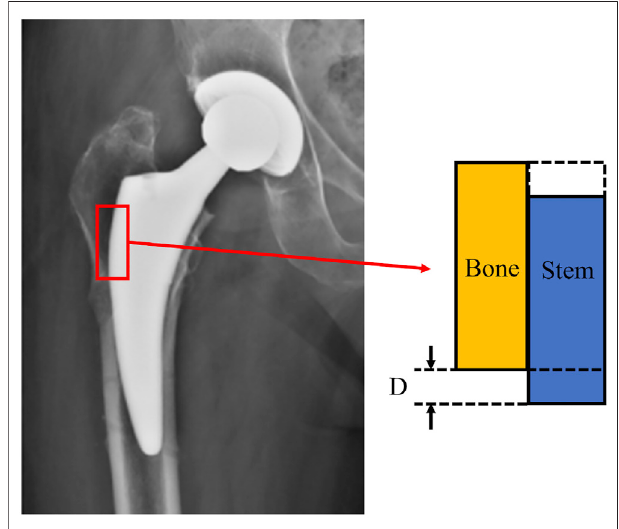
FIGURE 5 | Details of the bone-implant interface, D represents interface